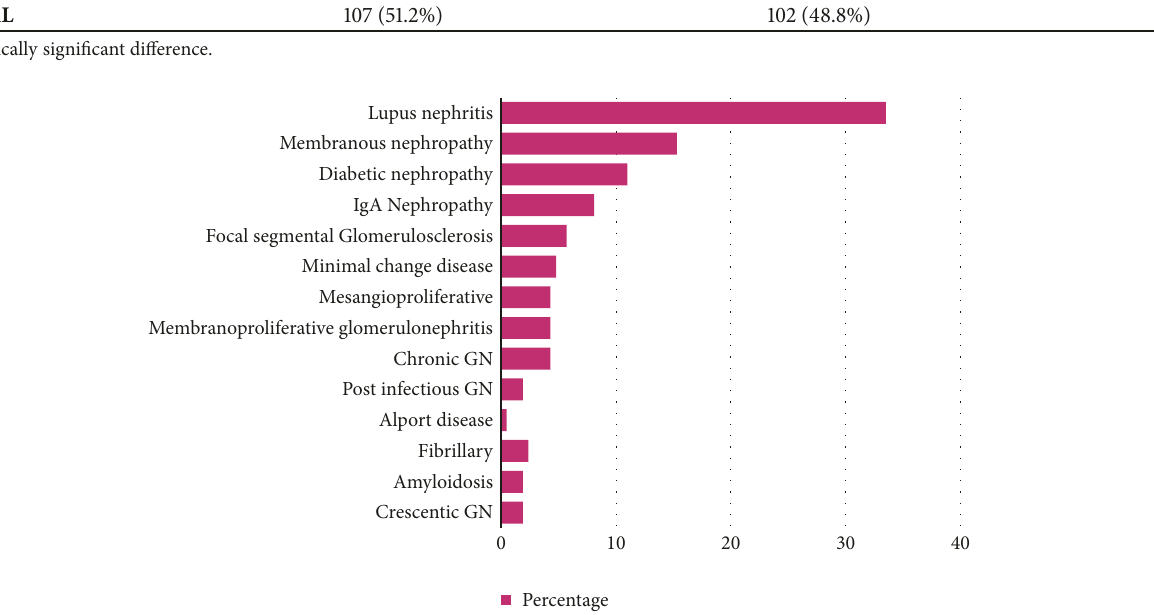
Figure 1: Incidence of different histopathological patterns of glomerulonephritis in the study population.